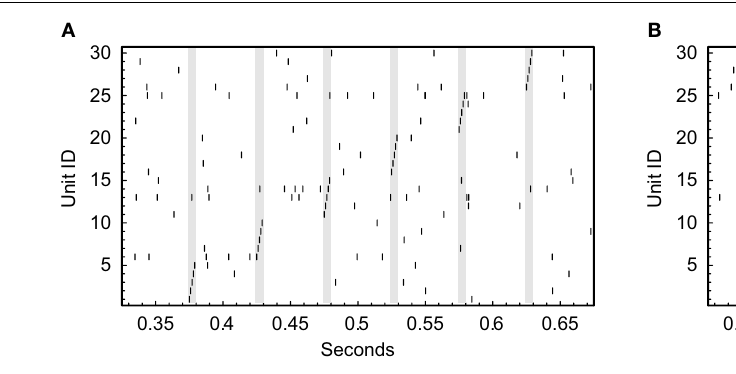
made up of six distinct patterns with exactly one spike per unit (periods of pattern occurrences highlighted in gray). (A) Some events co-occur by chance with the inserted patterns, complicating their detection (data types 3 and 4). (B) Events concurrent to but not participating in the inserted patterns have been removed to ensure the correct identification of the patterns (data type